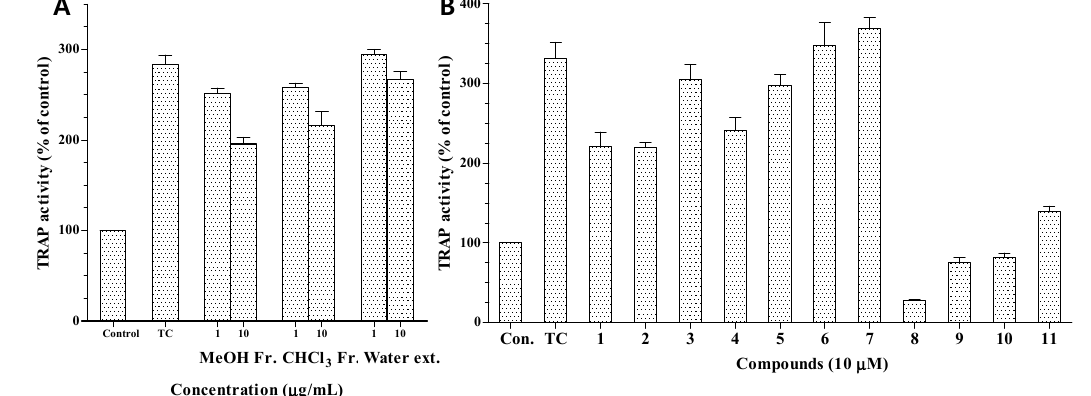
Figure 5. Inhibitory effects of the extracts ( A ) and compounds 1 – 11 ( B ) on TRAP activity of osteoclastic RAW 264.7 cells. Data are expressed as percentages of the values obtained with untreated cells. (Con.: control, which was not treated; TC: treated control, which was treated with RANKL).